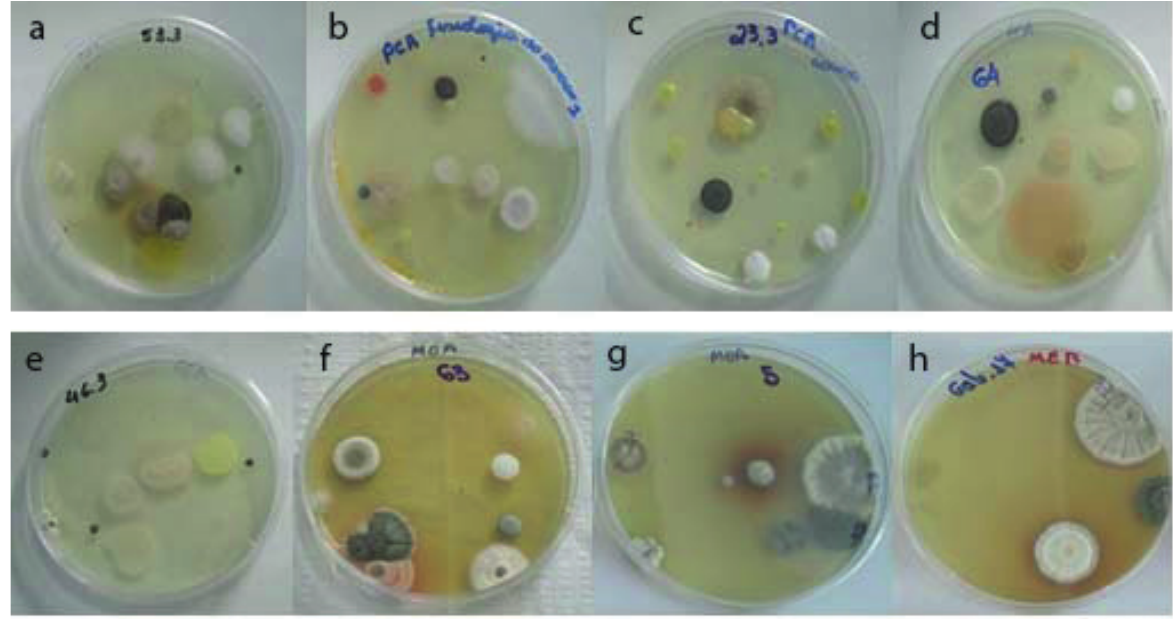
Figure 1 - Diversity of colonies of air bioaerosols of different environments of the Academic Center of Vitória - UFPE/CAV. Internal Commission for Accident Prevention - CIPA ( a ), Laboratory of Effort Physiology ( b ), Library - consultation collection room ( c ), Laboratory of Maternal and Child Nursing - LABEMI ( d ), Laboratory of Dietetic Technique ( e ), Laboratory of Semiology 2 and Clinical Evaluation ( f ), Nutrition Center ( g ), Library - study hall of the ground floor ( h ).